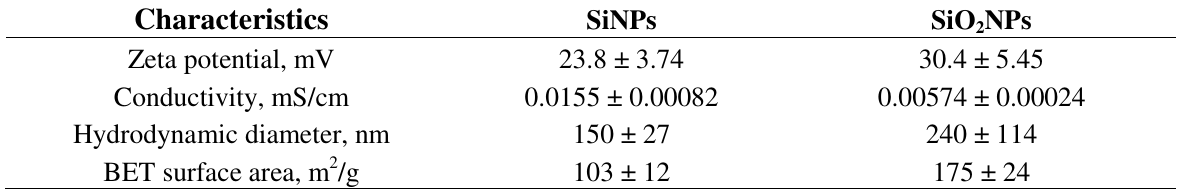
NPs. Values are means ± SD. 2